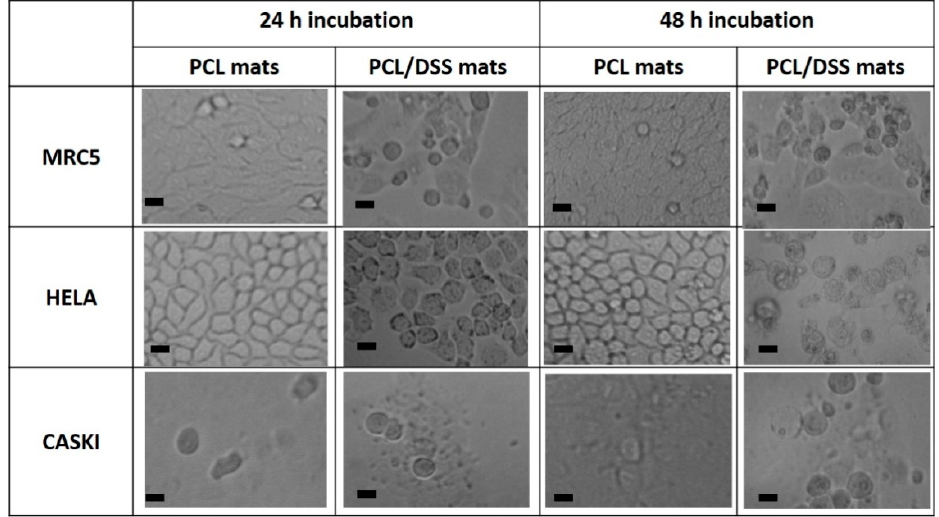
Figure 11. Microscopy images of cell line morphology. The scale bar corresponds to 20 µm.